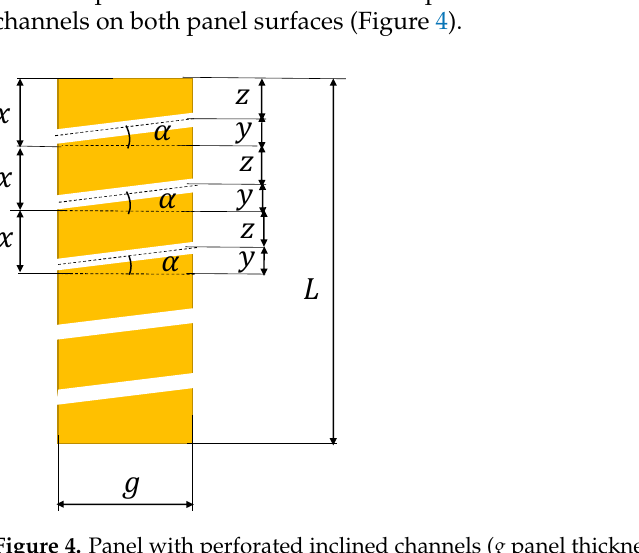
Figure 4. Panel with perforated inclined channels ( g panel thickness, x distance between the centers of channels, α inclination angle).